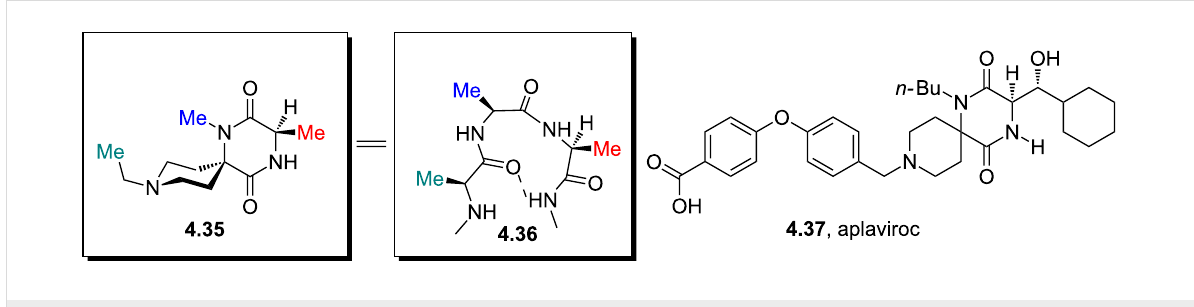
Figure 14: Structural comparison between the core of aplaviroc ( 4.35 ) and a type-1 β -turn ( 4.36 ).